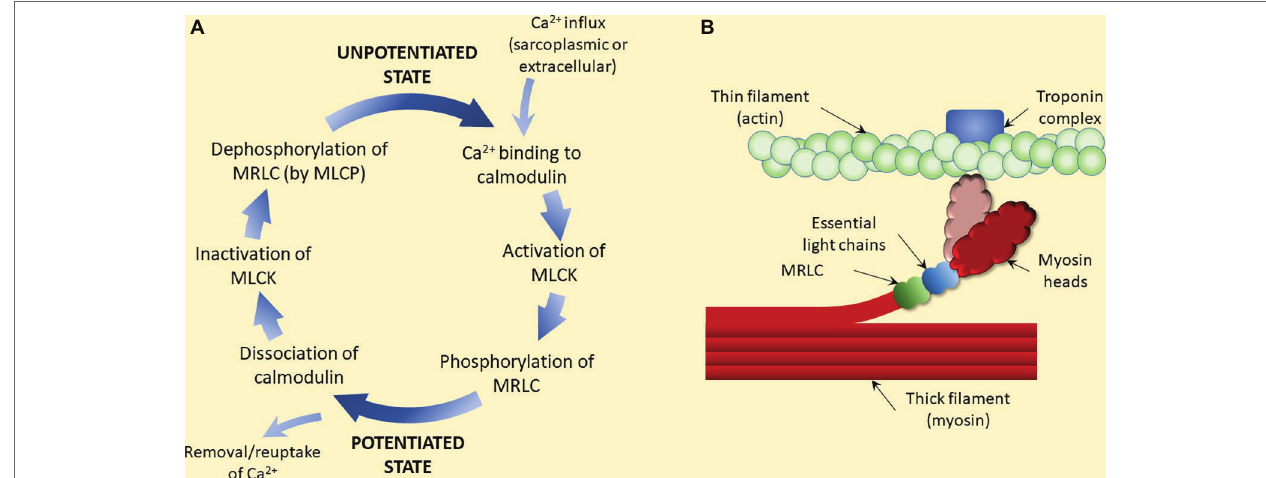
FIGURE 3 | Proposed mechanism of (classic) post-activation potentiation (PAP). (A) Calcium ions activate myosin light chain kinase (MLCK) subsequent to calcium-calmodulin interaction. MLCK then phosphorylates the myosin regulatory light chain (MRLC), which is believed to trigger the rotation of the myosin head away from the thick filament (myosin backbone) toward the thin filament (light color myosin head in panel B). Removal or reuptake of calcium triggers the dissociation of calmodulin and inactivation of MLCK. Dephosphorylation of the MRLC by myosin light chain phosphatase (MLCP) completes the process of potentiation removal. (B) MRLC phosphorylation and subsequent rotation of the myosin head (light color) increases the probability of the head attaching to actin, and thus force production. At submaximal (i.e., below saturating) levels of calcium, this process increases force output at a given calcium concentration, i.e., calcium sensitivity. Since phosphorylation is rapid but dephosphorylation is relatively slow, a period of contractile activity (e.g., a warm-up period) is sufficient to augment contractile properties in subsequent contractions, even if a short period of rest is imposed (e.g., contractions are intermittent) (Manning and Stull,